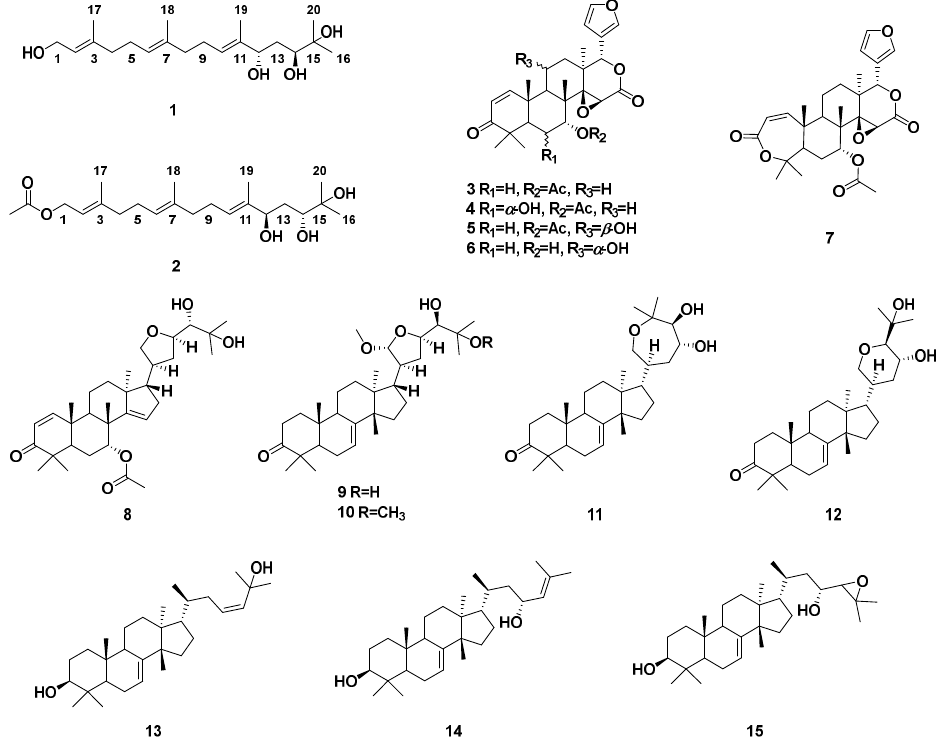
Figure 1. Structures of compounds 1 – 15 from the seeds of T. sinensis.